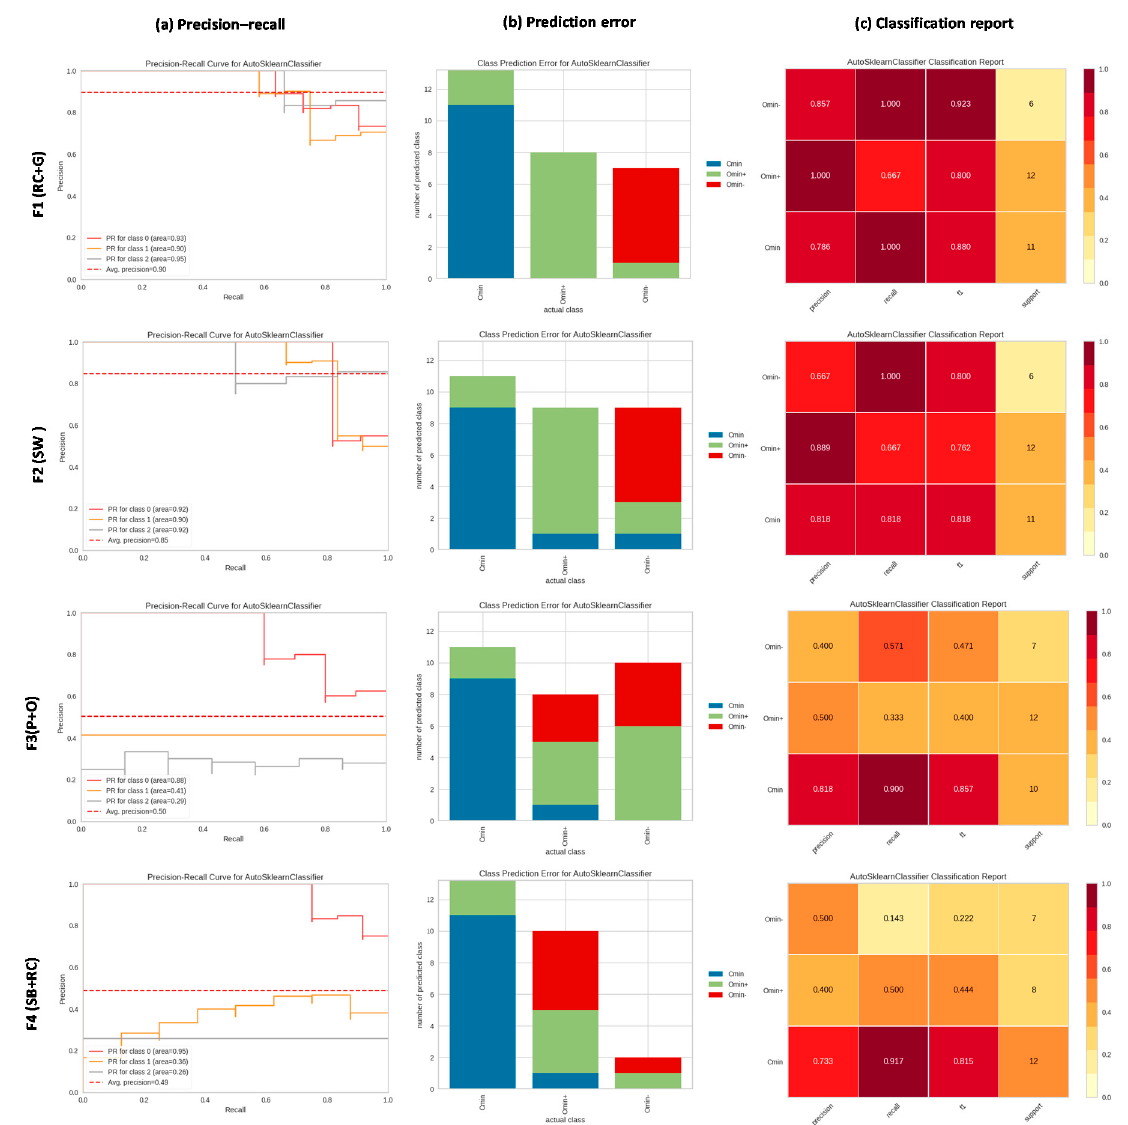
Figure 6. The evaluation of AutoML classification of AMPs from the acquisition of the UAS-VIs DN in May. ( a ) Precision– recall, where the class 0, 1, 2 equals to Cmin+, Omin+, and Omin-, respectively ( b ) Prediction error (confusion matrix), the X -axis represents the three subclass form CM result in May, and the Y -axis represents the type (with color), and the number of correct or incorrect estimates., and ( c ) Classification report lists the precision, recall, and F1-score per class as a heatmap for overall comprehensive evaluation results. The calculation methods used in this figure are shown in Table 3.